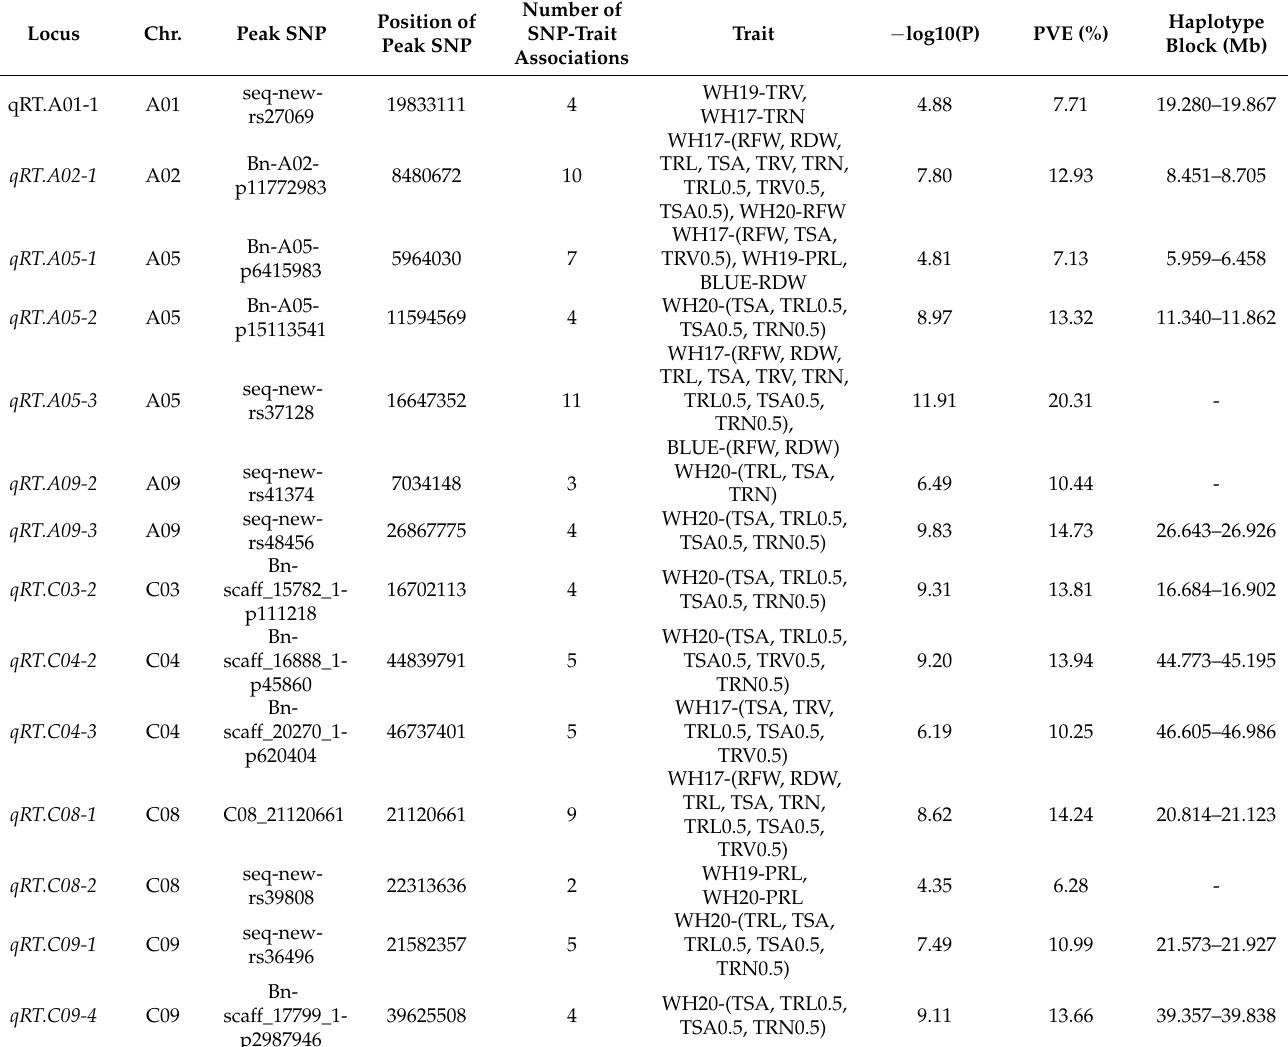
Table 3. Information of crucial QTL clusters related to root